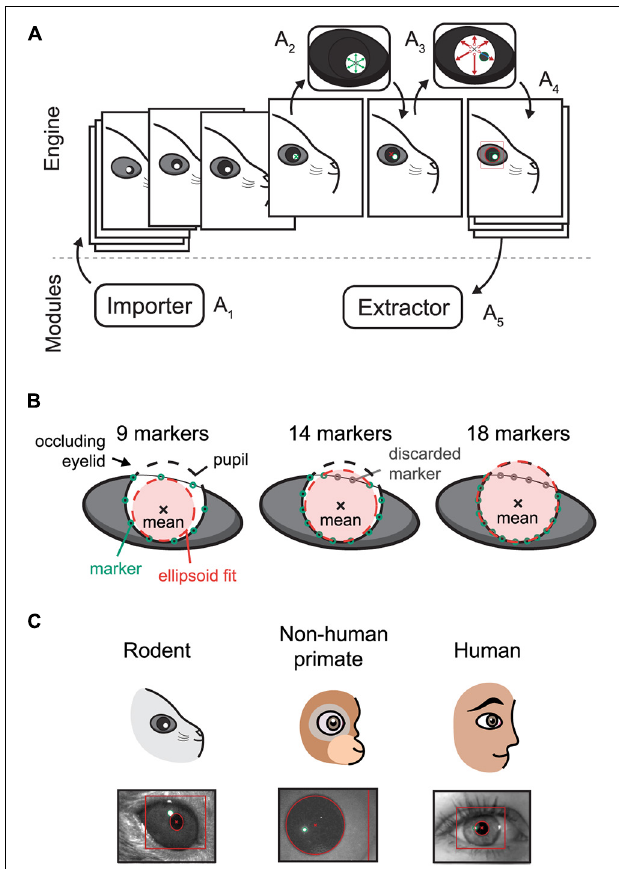
FIGURE 1 | Schematic overview of the EyeLoop algorithm and its applications. (A) Software overview. The engine exchanges data with the modules. The Importer module imports camera frames in a compatible format (A 1 ) . The frame is binarized and the corneal reflections are detected by a walk-out algorithm (A 2 ) . Using the corneal reflections, any pupillary overlap is removed, and the pupil is detected via walk-out (A 3 ) . Finally, the data is formatted in JSON and passed to all modules, such as for rendering (A 4 ) , or data acquisition and experiments (A 5 ) . (B) Occlusion filtering. EyeLoop tracks 32 points along the pupil contour by default. By computing the statistical mean of the data points and the standard deviation difference to the mean, EyeLoop filters the points to discard “bad” markers. Users can increase the number of markers in-code to produce better fits. (C) EyeLoop accepts a variety of animal eyes, including rodents, non-human primates, and humans, by employing distinct mathematical models for each type of